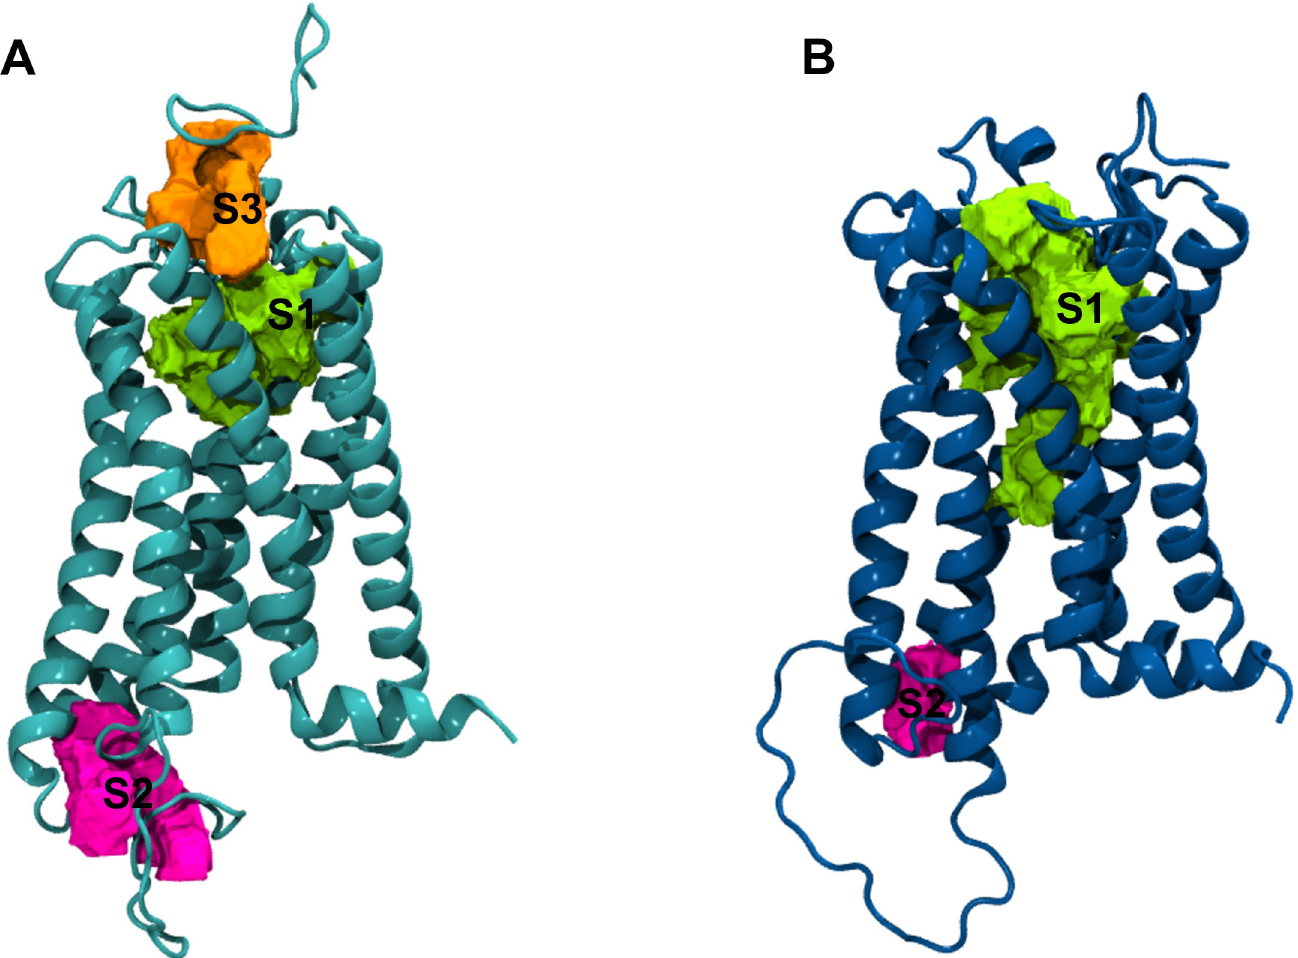
Fig 4. Binding sites identified in the CB 1 R. (A) Conformation of the CB 1 R bound to agonist. (B) Conformation of the CB 1 R bound to antagonist. Orthosteric site S1 (green) and potential allosteric binding sites S2 (magenta) and S3 (orange).